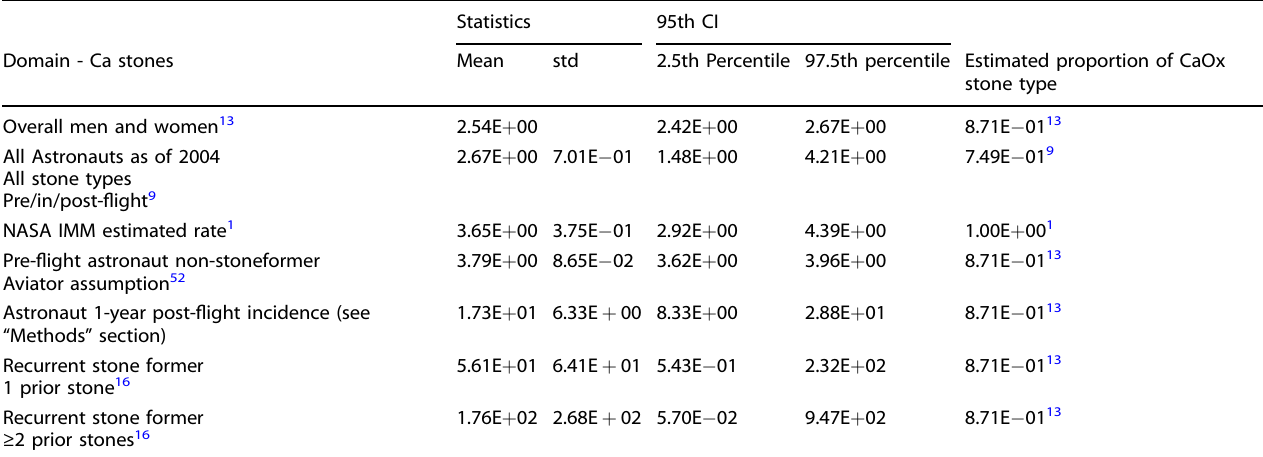
Table 4. Estimated incidence and recurrence rates of calcium-based symptomatic kidney stones (rates in events per 1000